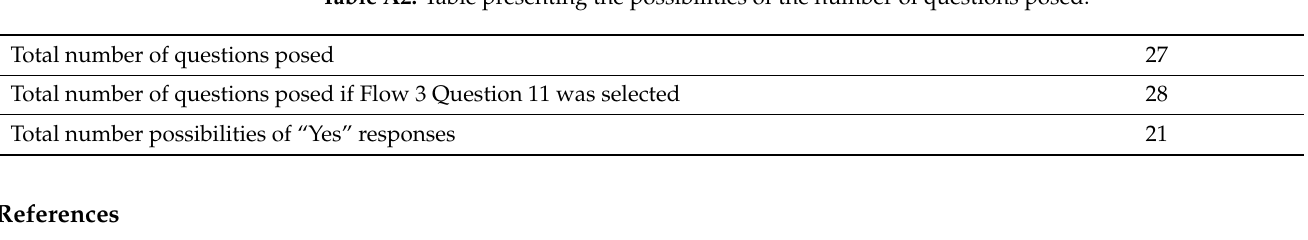
Table A2. Table presenting the possibilities of the number of questions